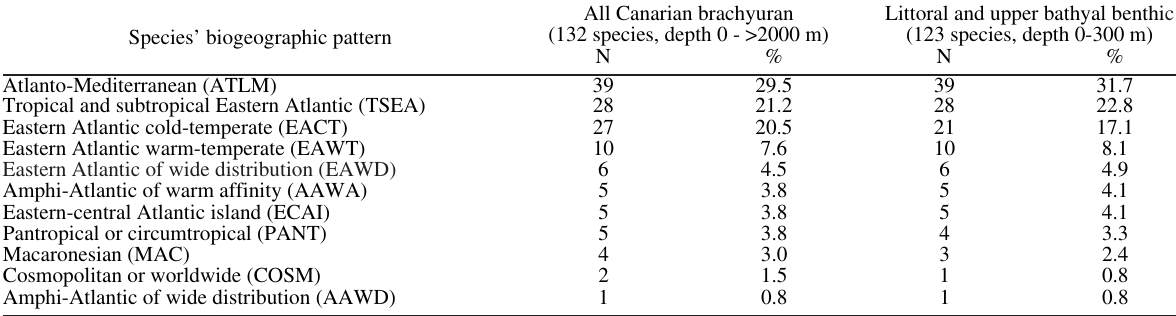
pattern. All Canarian brachyuran Littoral and upper bathyal benthic (132 species, depth 0 - >2000 m) (123 species, depth 0-300 m) N % N %